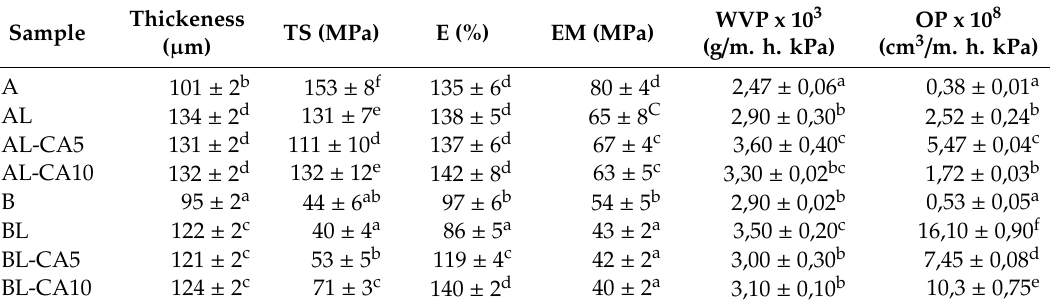
Table 3. Tensile parameters (Tensile strength (TS), percentage elongation (E) and elastic modulus (EM)) and barrier properties (water vapour permeability, WVP; oxygen permeability, OP of the films. Mean values and standard deviation, in brackets.